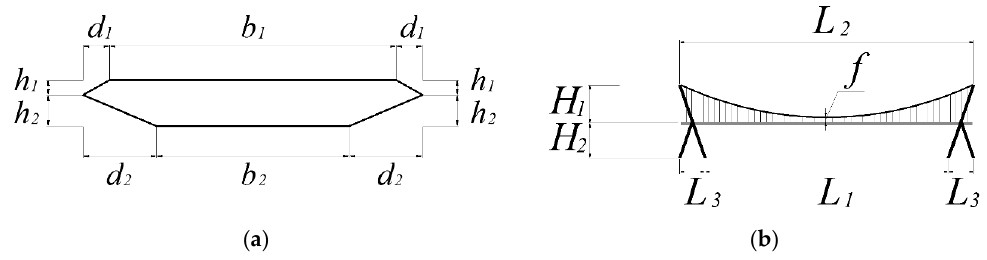
Figure 2. Geometry parameters: close box section ( a ), pedestrian bridge outline ( b ) [20].